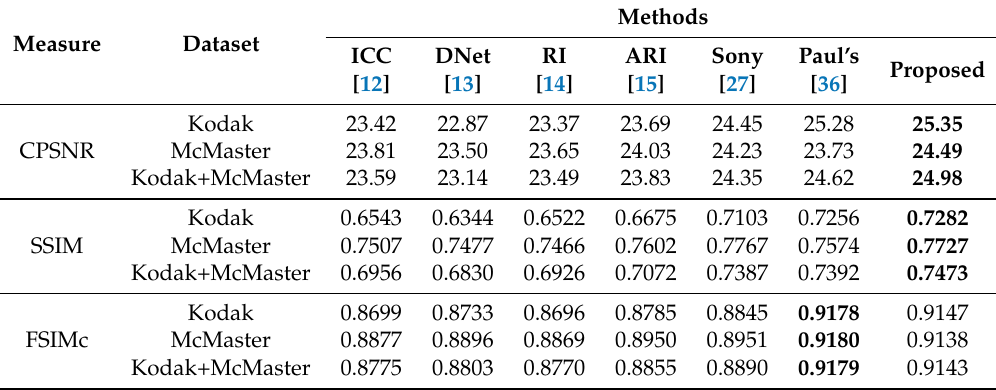
Table 2. Comparison of the CPSNR, SSIM, and FSIMc values between the various demosaicing methods on the Kodak, the McMaster, and the Kodak+McMaster image datasets under the high-noise condition. The bold texts represent the largest